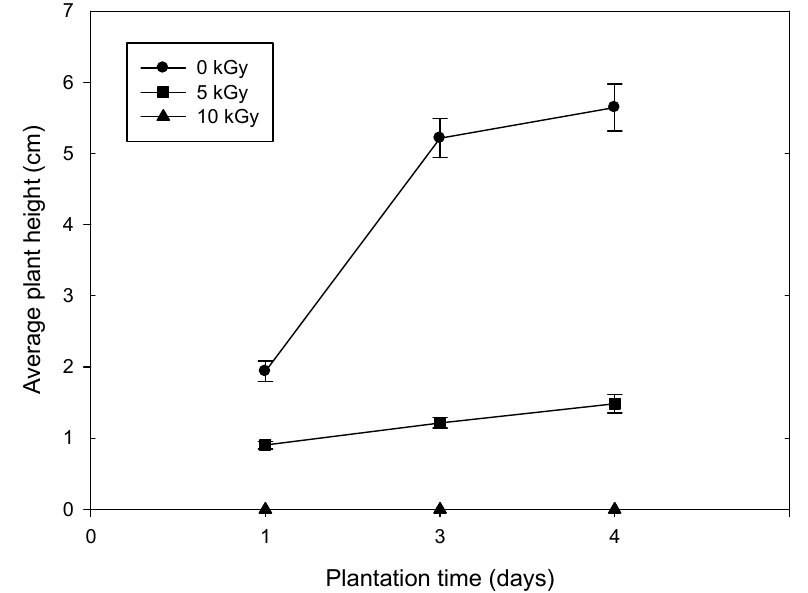
Figure 2. The changes in plant height under various doses of gamma-ray irradiation (mean ± standard deviation, N = 20/group). standard deviation, N =